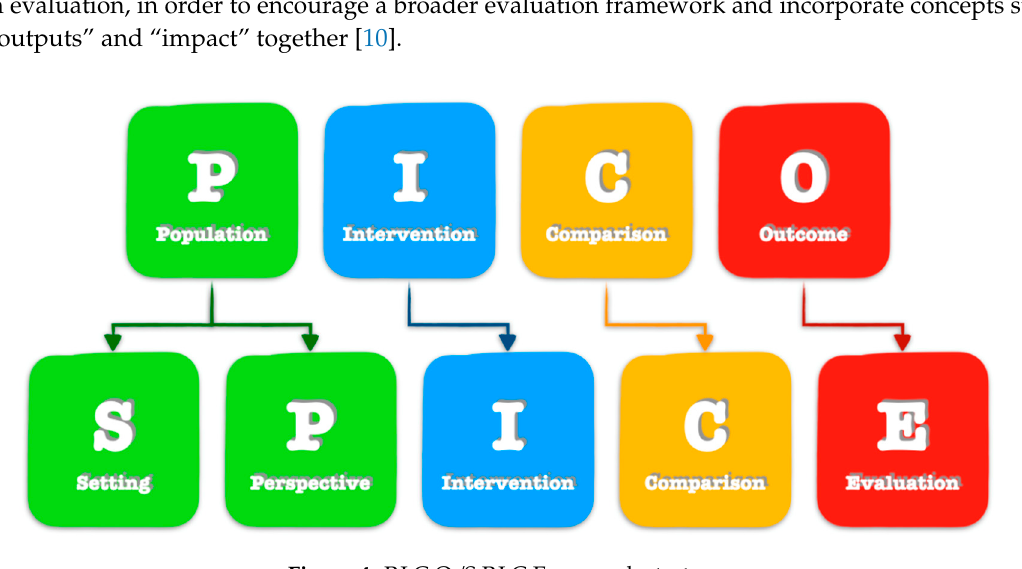
Figure 4. P.I.C.O. / S.P.I.C.E. research Figure 4. P.I.C.O./S.P.I.C.E. research strategy.